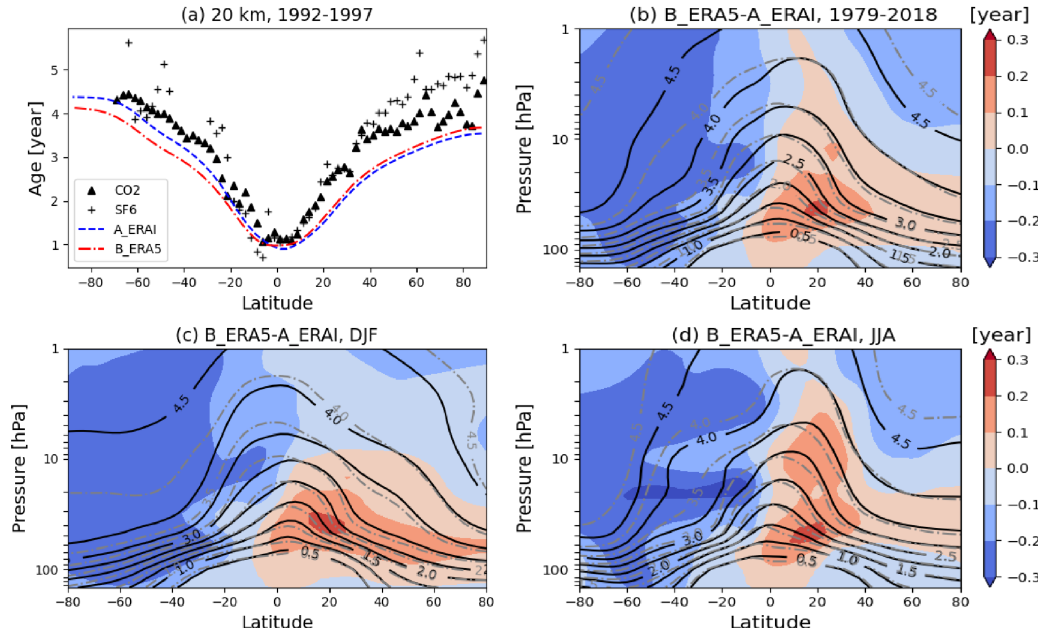
Figure 10. (a) Mean age of air (AoA; years) at 20km at different latitudes from in situ observations of CO 2 , SF 6 (black symbols; from Hall et al., 1999), A_ERAI (blue solid line), and B_ERA5 (red dash-dotted line). (b) Pressure–latitude cross section of mean age from A_ERAI (black solid contours) and B_ERA5 (grey dash-dotted contours) and their differences (B_ERA5–A_ERAI; red and blue shading) averaged over 1984–2018. Panels (c) and (d) are similar to (b) but for DJF and JJA means, respectively.